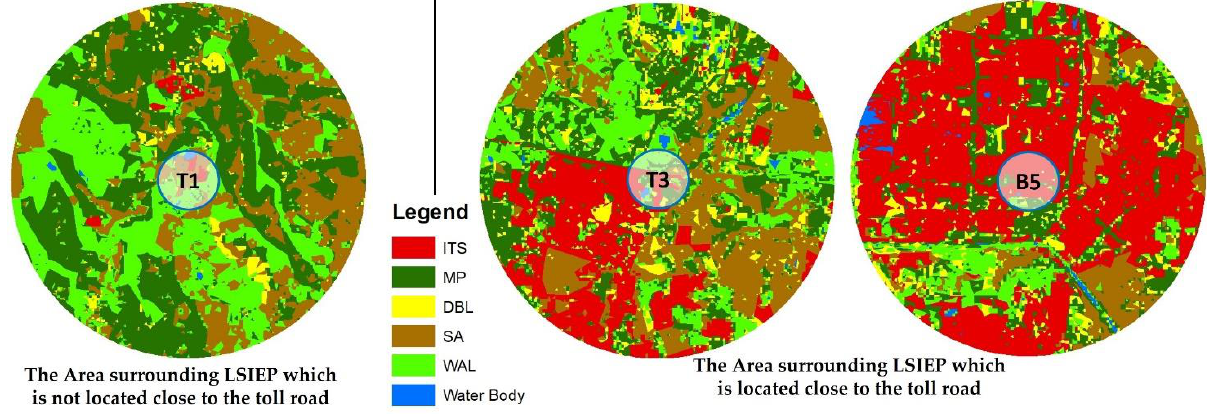
Figure 7. LUC around the selected LSIEP location.